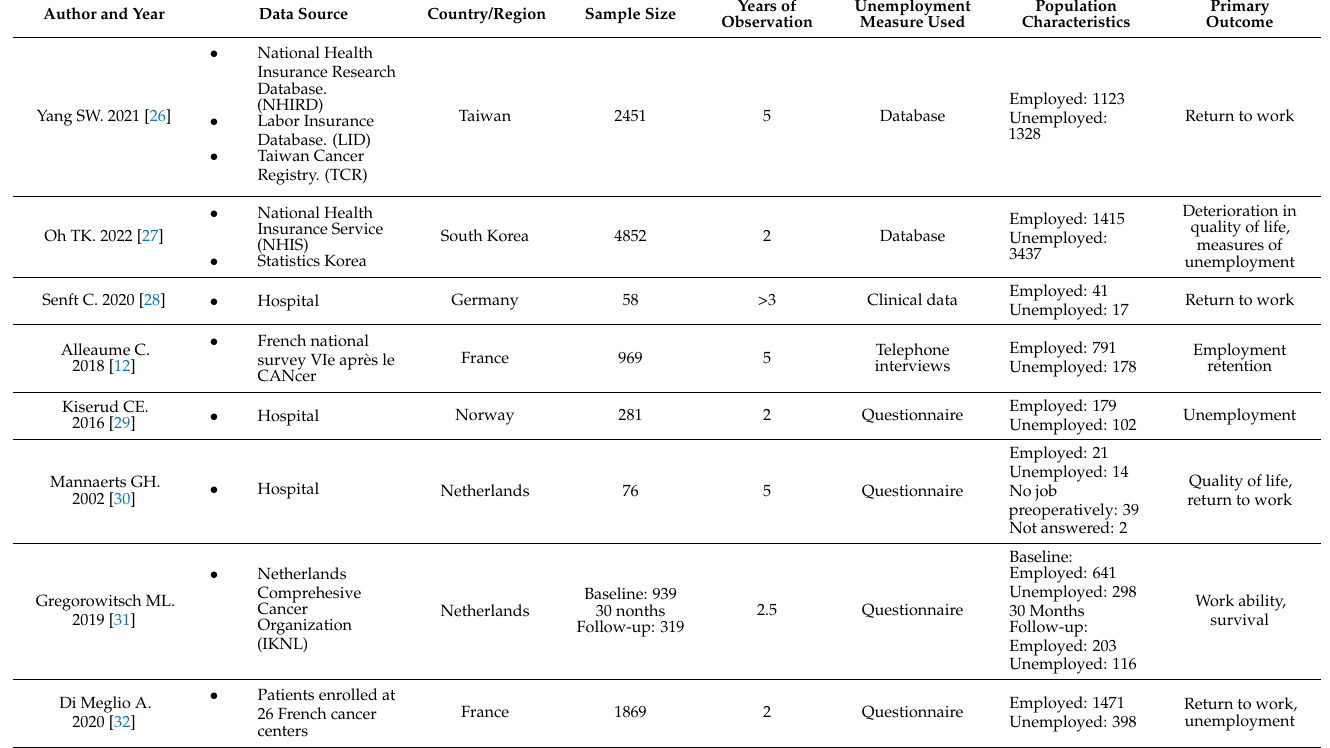
Table 1. Characteristics of selected studies.